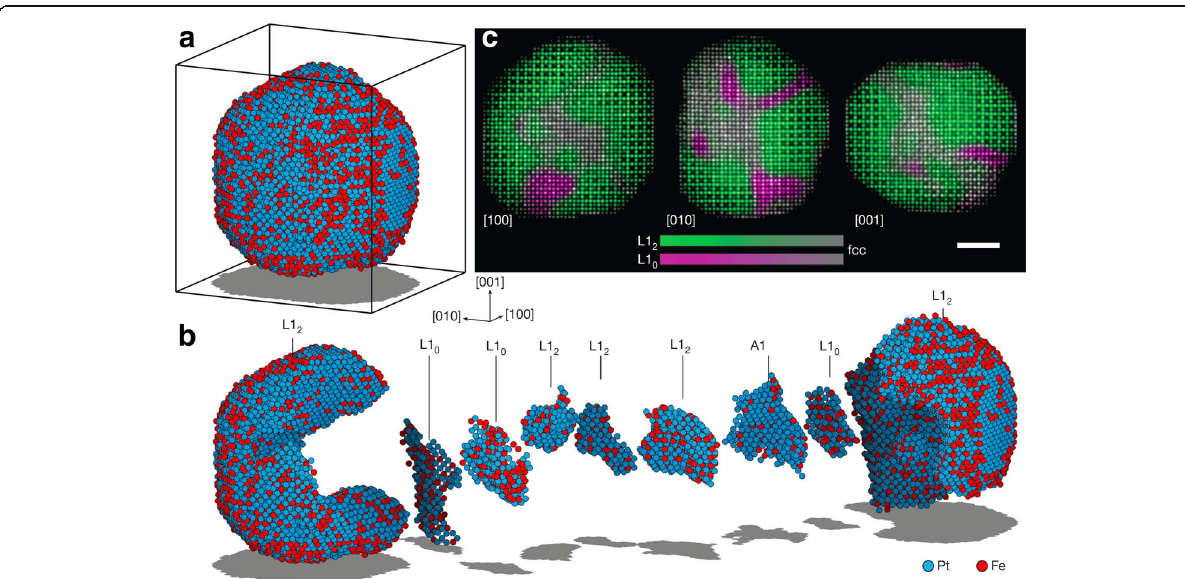
Fig. 19 3D determination of atomic coordinates, chemical species, and grain structure of an FePt nanoparticle. a Overview of the 3D positions of individual atomic species with Fe atoms in red and Pt atoms in blue. b The nanoparticle consists of two large L12 grains, three small L12 grains, three small L10 grains, and a Pt-rich A1 grain. c Multislice image. Reproduced from Yang et al. 2017, by permission from Springer Nature. Copyright 2017